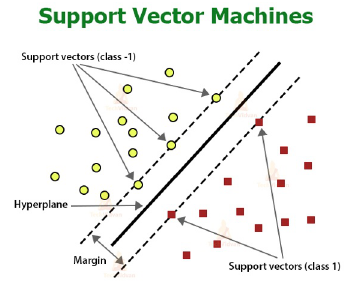
Figure 1. Support Vector Machine